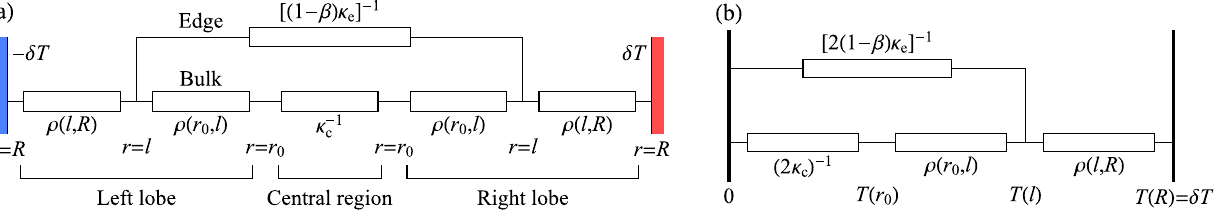
FIG. 3. (a) Effective heat-resistor network of the phonon-coupled chiral spin liquid. Each resistor represents a heat-carrying component of the system, with the resistors in the upper (lower) row accounting for the edge mode (bulk phonons). The right and left leads are fixed at temperatures δ T and − δ T , respectively. (b) Reduced heat-resistor network representing the right half of the system. The right lead is fixed at temperature δ T , while the center of the system is fixed at temperature